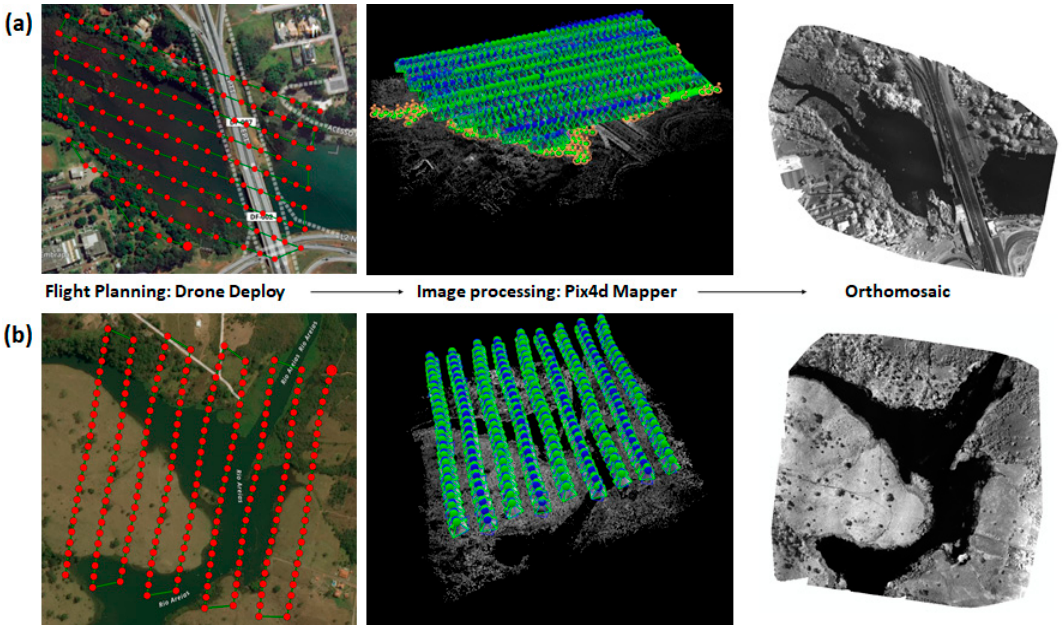
Figure 6. Simplified orthomosaic building process highlighting the position of each image generated through autonomous flights (left) and the steps of image alignment and 3D point cloud in Pix4Dmapper (center) in the Paranoá ( a ) and Corumbá IV ( b ) reservoirs. Considering overlapping images, Pix4Dmapper calculated the reflectance values for each pixel of the orthomosaics using a weighted average of the pixels in all of the original images that correspond to this particular pixel but assigning more weight to images where the pixel is more central. The image pixel value depends on a series of factors that include sensor settings, sensor properties, and scene conditions. Radiometric corrections are applied to improve the quality of the data using the camera, irradiance, and sun angle parameters for clear skies and camera and irradiance for overcast skies. These parameters are obtained from the Exif metadata for each image. The camera parameters are exposure time, shutter speed, vignetting, dark current, and ISO value. The irradiance sensor provides a record of the light conditions during the flight in the same spectral bands as the ones captured by the multispectral sensor. The sun angle parameter takes into account the direction of the incoming sun ray, and its projection onto the scene and onto the sun sensor. Thus, Pix4Dmapper can normalize the images captured during the flight and thus allows comparing images taken in different illumination conditions [23]. 2.3. In Situ Measurements Figures 3 and 4 shows the sampling points where we collected field data during unmanned airborne surveys. Spectroradiometric data were collected during two surveys over the Corumbá IV reservoir (March 29th, 2018 and May 18th, 2018). Water quality parameters, namely TSS concentration and water transparency ( Z SD ), were measured during all flight campaigns (Table 2). Spectroradiometric data were recorded using TriOS RAMSES hyperspectral spectroradiometer following the protocol proposed by Mobley [24] for above water measurements. Downwelling irradiance ( E d ) was measured using a cosine sensor. Upwelling radiance ( L u ) was measured with a 40° off-nadir viewing angle and a 135° azimuth angle from the sun during the drone surveys according to [25]. For direct comparison with drone-derived at-sensor reflectance, we computed reflectance ( R ) as R = L u / E d . Water surface samples (~20 cm deep) were collected at the sampled points and processed at the Geochemistry Laboratory of the University of Brasília to determine TSS concentrations according to